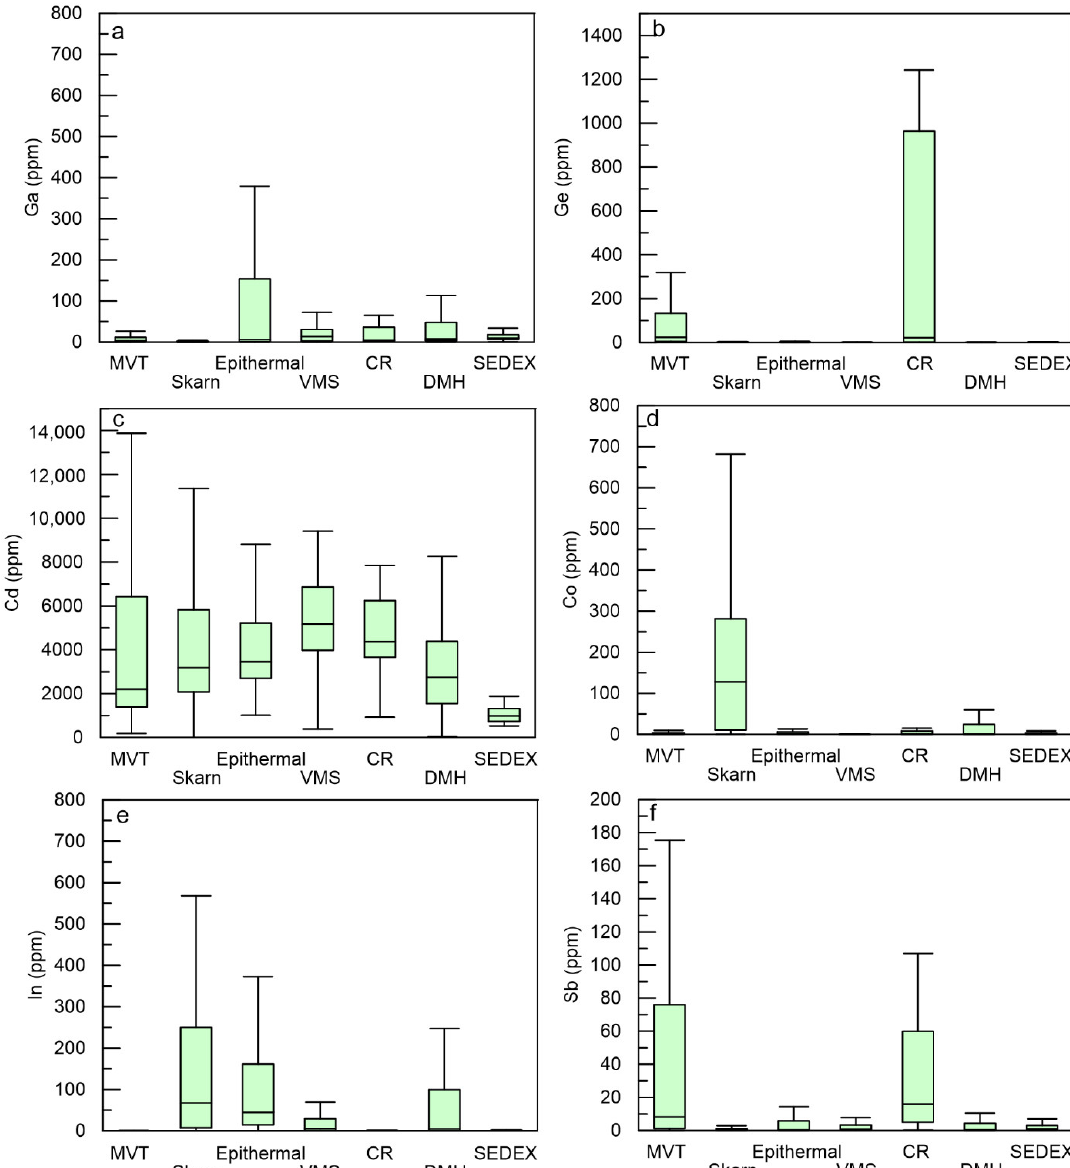
Figure 5. Critical metals in sphalerite from different types of deposits. Germanium is considered to be mainly hosted in MVT sphalerite (Figure 5b). The Mayuan MVT deposit in China has the highest reported Ge contents (1305 ppm), with a mean value of 609 ppm [8]. Other MVT deposits, such as Dalingzi (China), Huize